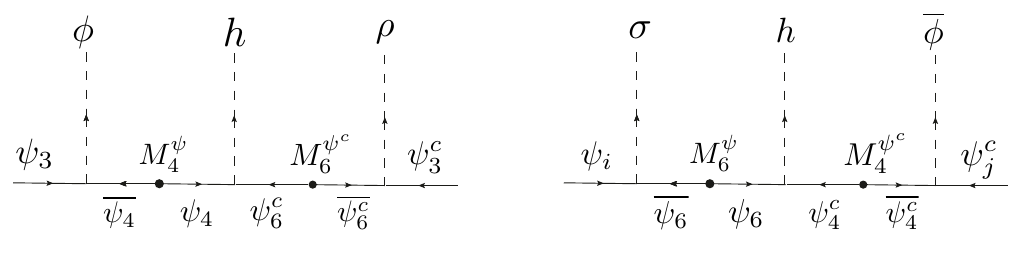
Figure 7 . Diagrams in the 2HDM version which lead to the effective Yukawa couplings of the third family (left panel) and second family (right panel) where i, j = 2 , 3 are the only non-zero values. These arise from figure 2, with H replaced by ( h ⊗ ρ ) , and H replaced by ( h ⊗ σ )